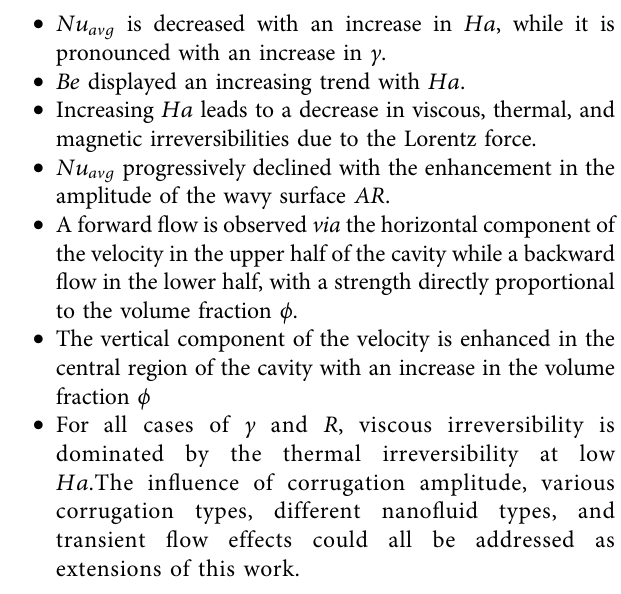
Frontiers in Physics |